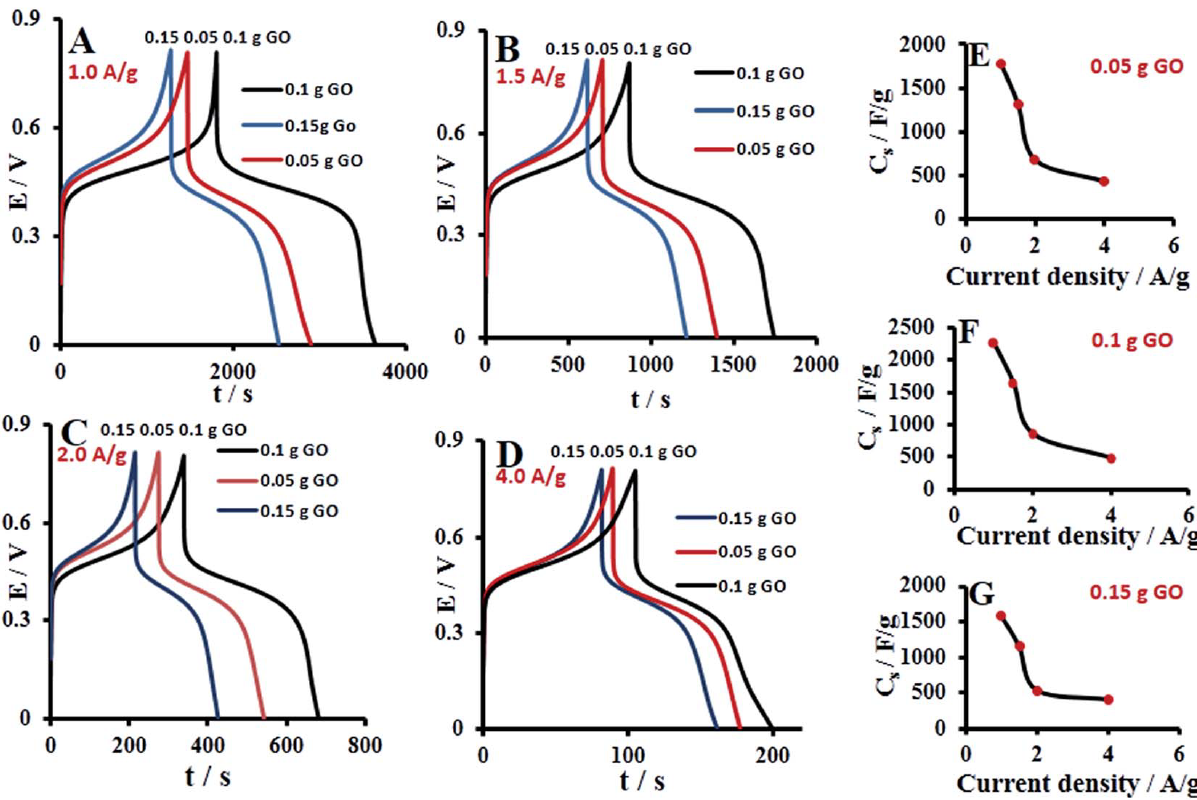
Figure 13: The GCD at current densities of (A) 1.0 A · g −1 , (B) 1.5 A · g −1 , (C) 2.0 A · g −1 , and (D) 4.0 A · g −1 were obtained in the presence of various amounts of GO; (E)–(G) show the specific capacitance vs. the current density curves obtained from